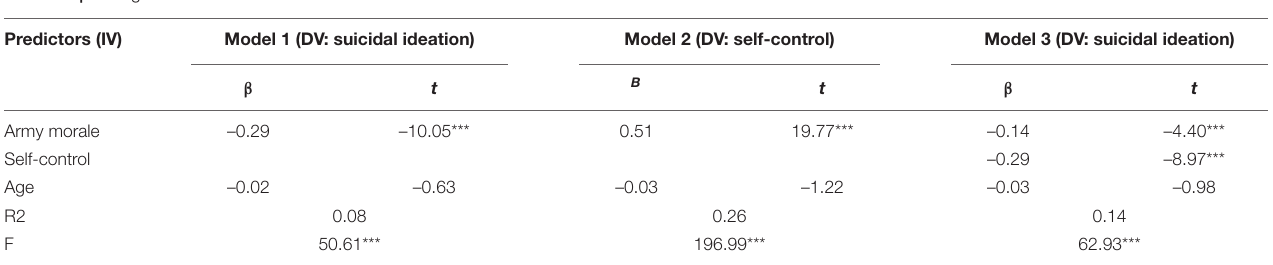
TABLE 2 | Testing the mediation effect of self-control.